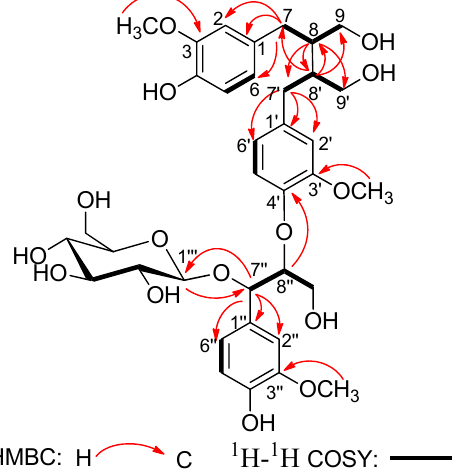
Figure 2. Key HMBC and 1 H- 1 H COSY correlations of compound 1